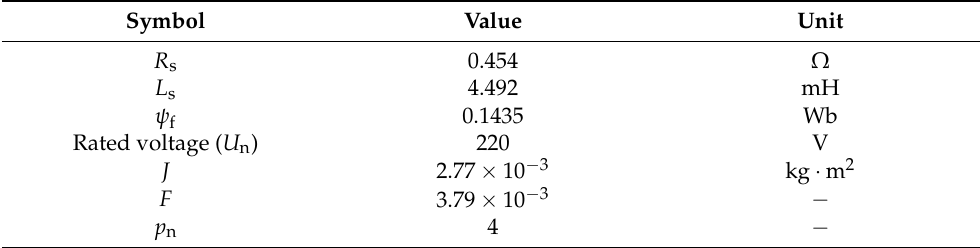
Table 1. Specification parameters of a surface-mounted